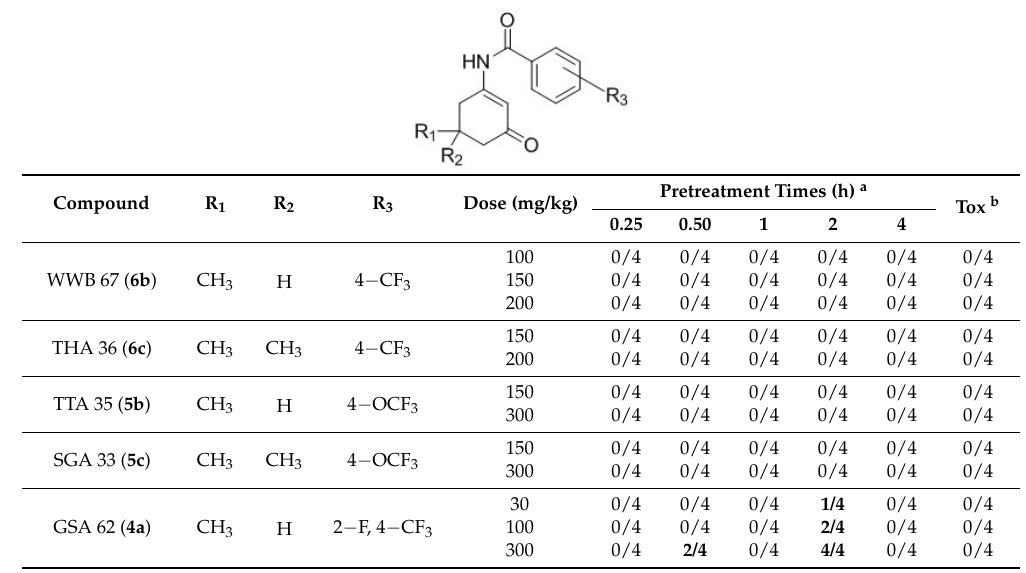
Table 2. Anticonvulsant activity: maximal electroshock (MES) test in mice.